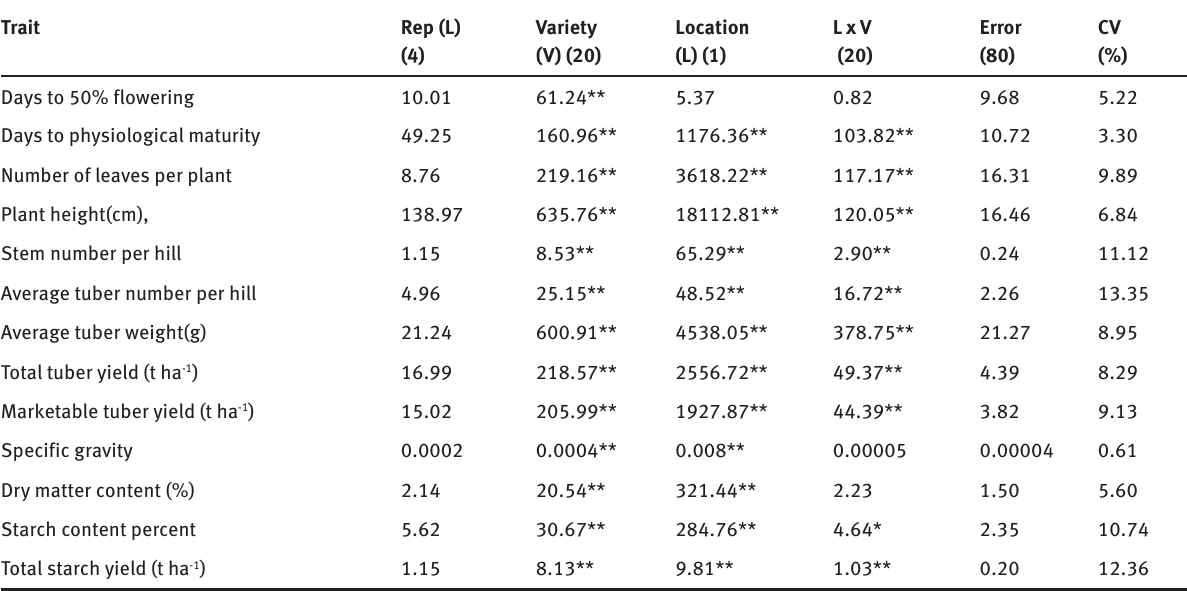
Table 3: Mean squares from combined analysis of variances over locations for 14 traits of 21 potato varieties in 2017